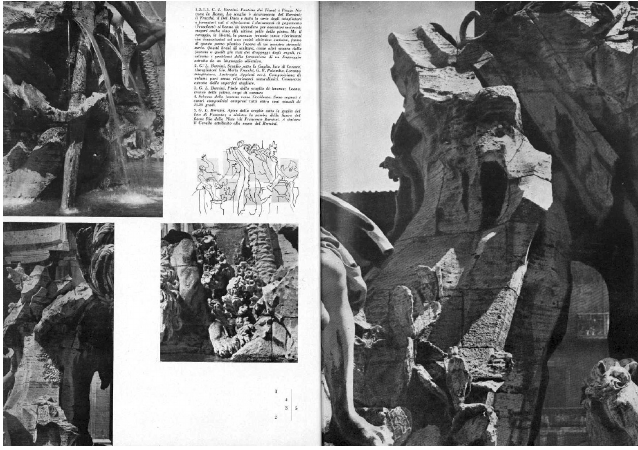
Fig. 8 Luigi Moretti,